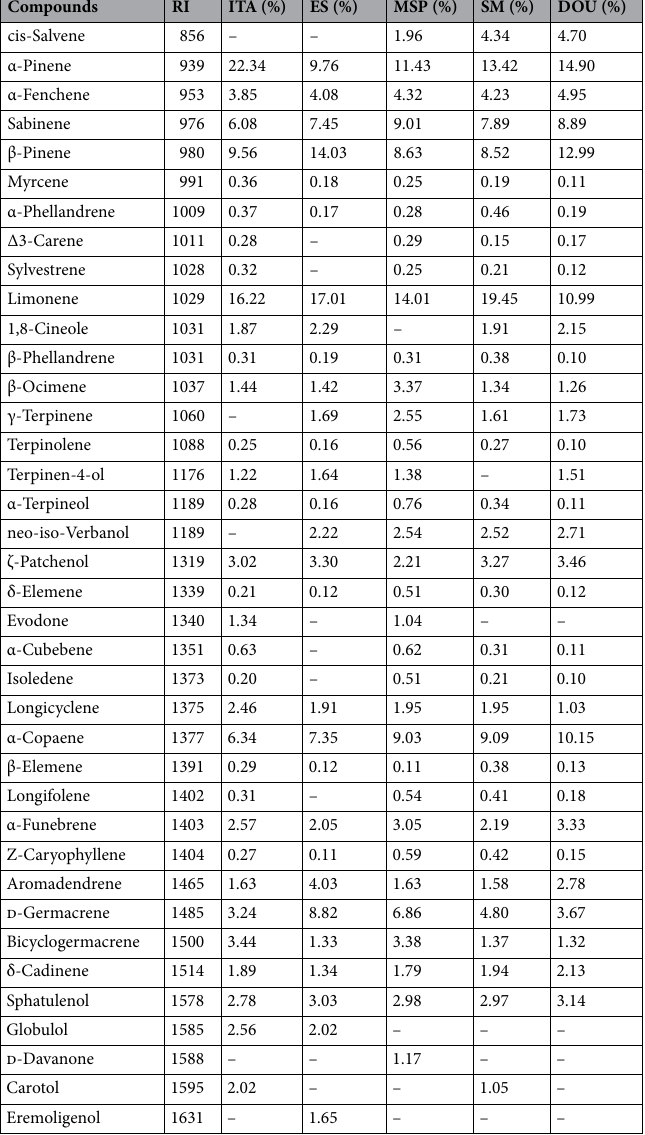
Table 6. Comparison of chemical profiles of the essential oil from fresh berries of S. terebinthifolia collected in five native populations from the Atlantic Forest Biome. RI, Retention index calculated; ITA, Itaparica (sandbank); ES, São Mateus (dense ombrophilous forest); MSP, Morro de São Paulo (sandbank); SM, Santa Maria (deciduous seasonal forest) and DOU, Dourados, MS (savanna). For those cells represented by “–” means the compound was not detected in that